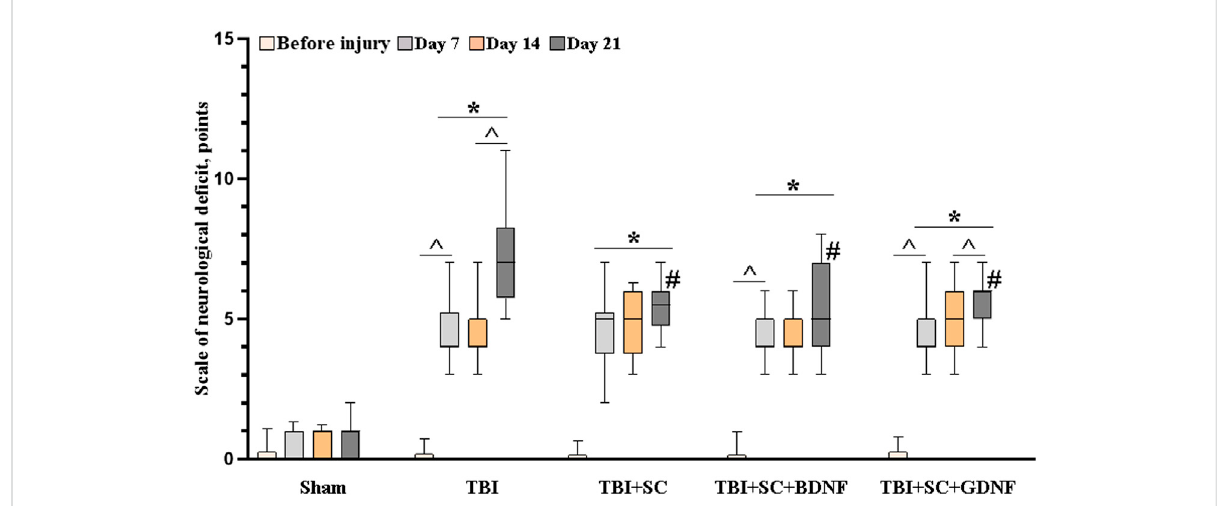
FIGURE 5 Neurological status assessment in mice after traumatic brain injury followed by scaffold implantation. Data presented as “ M [Q1; Q3], ” where M — median, Q1 — fi rst quartile (quantile 0.25), and Q3 — third quartile (quantile 0.75) of two independent experiments; the number of mice for each group comprise at least 10 individual animals. Statistical signi fi cance was calculated by the Mann-Whitney test * - versus Sham, # - versus TBI, p < 0.05, and by the Wilcoxon test ^ - versus day 7, p <